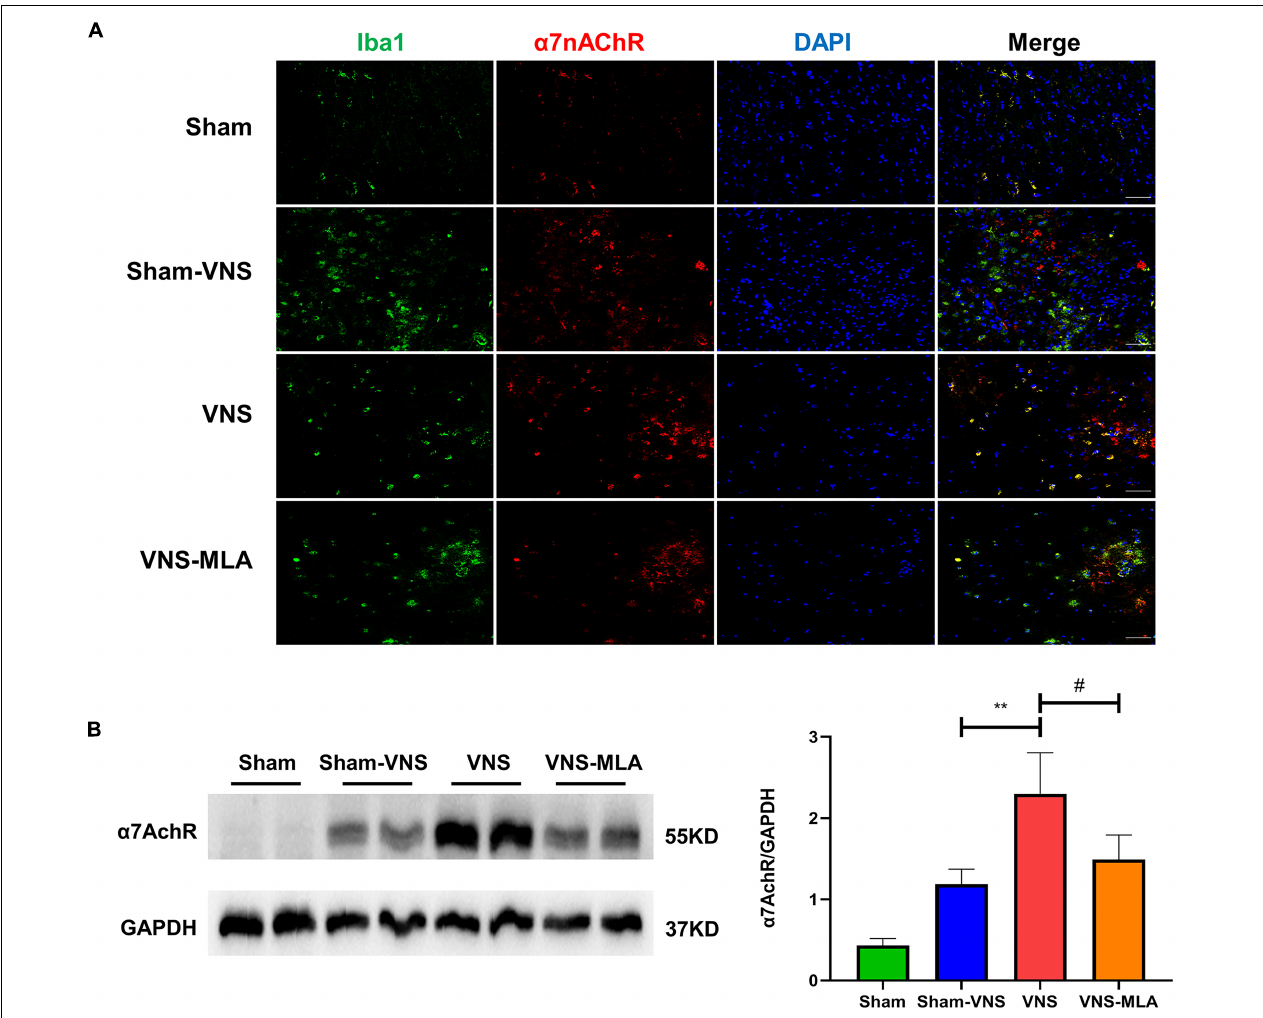
FIGURE 7 | Vagus nerve stimulation (VNS) improves recovery via α 7Acher. (A) α 7nAChR labeled cells (green) express Iba-1 (red) in the spinal cord, n = 5 per group, scale bar = 50 µ m. (B) Western blot analysis of α 7nAChR expression and the spinal cords were collected at 3 days after injury, n = 4 per group. ** P < 0.01 VNS vs. Sham-VNS group. # P < 0.05 VNS vs. VNS-MLA